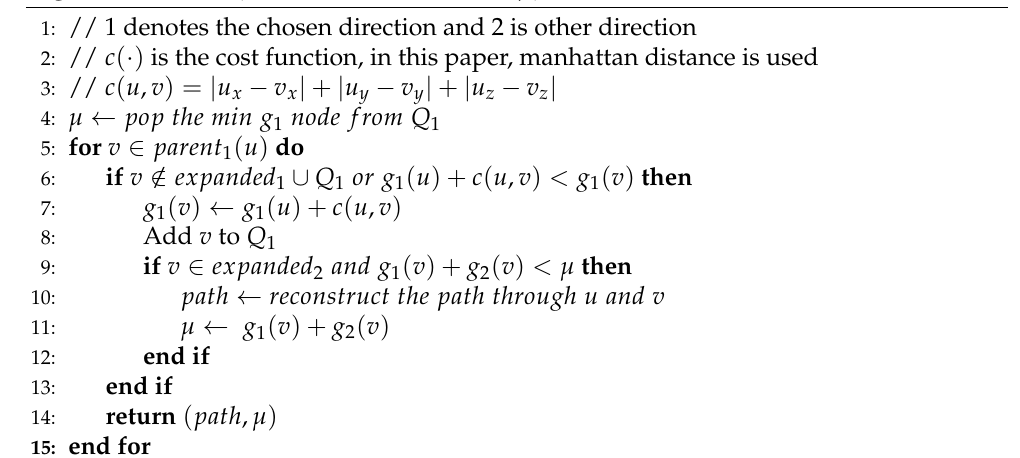
Algorithm 5 STEP ( search 1 , search 2 , solution , µ )